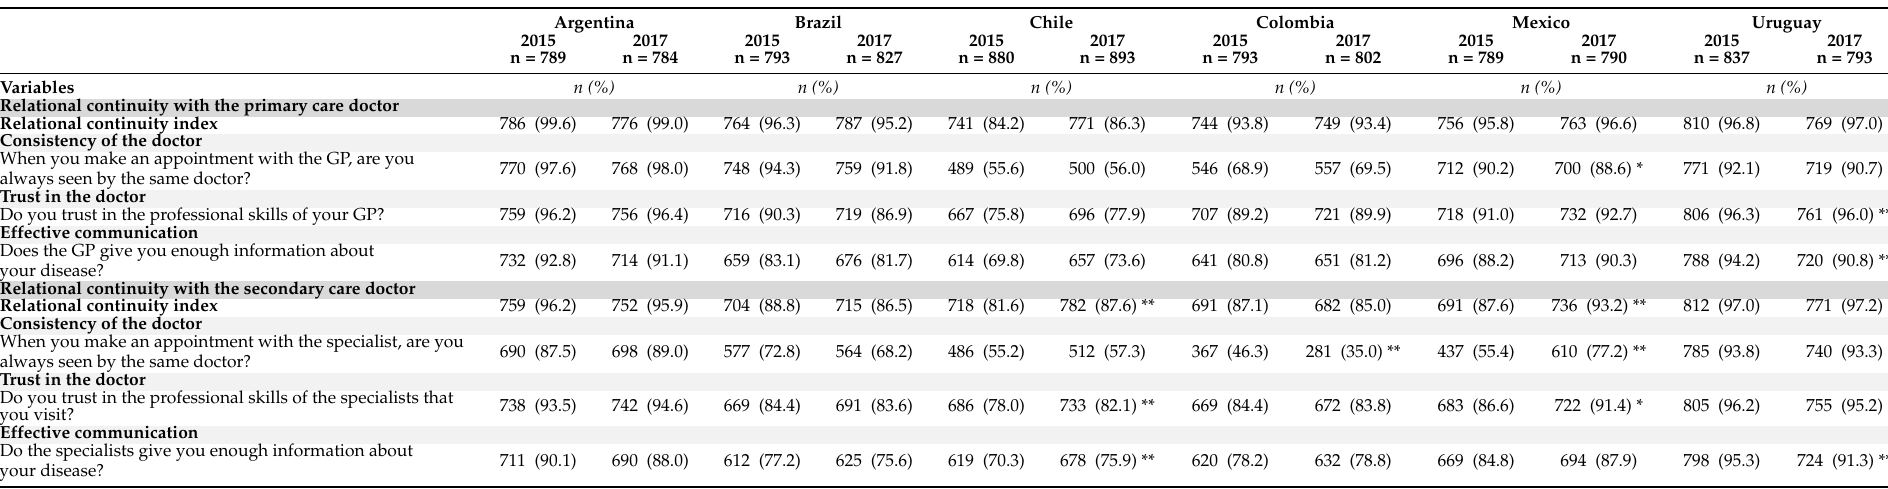
Table 2. Prevalence of perceived high level of relational continuity with primary care doctor and with secondary care doctor in the health services networks studied, by country and year. Argentina Brazil Chile Colombia